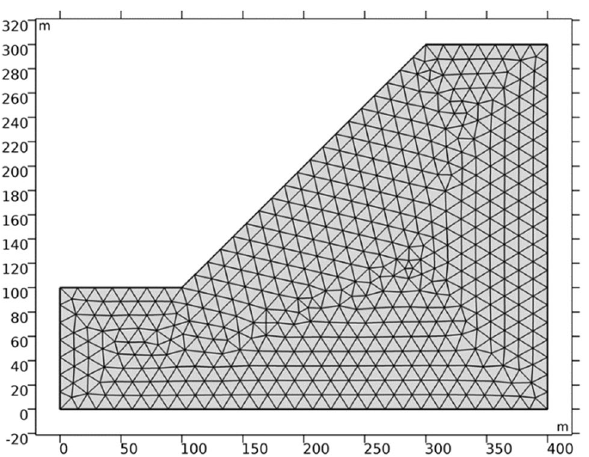
Figure 6. Slope model establishment and grid division.